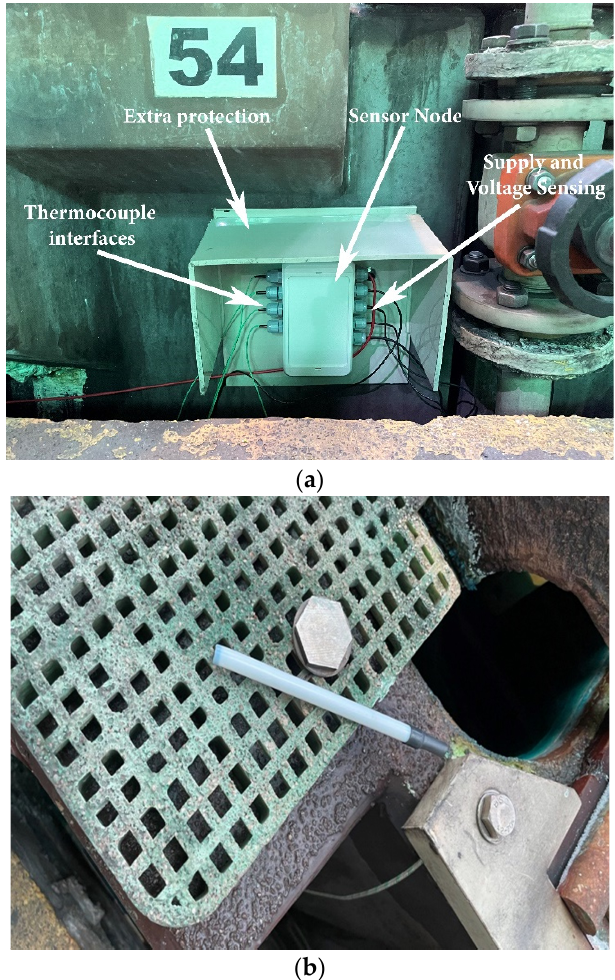
Figure 8. ( a ) Sensor node installed to cells at the Atlantic Copper factory (Huelva, Spain). ( b ) Ther- mocouple with protection capsule.